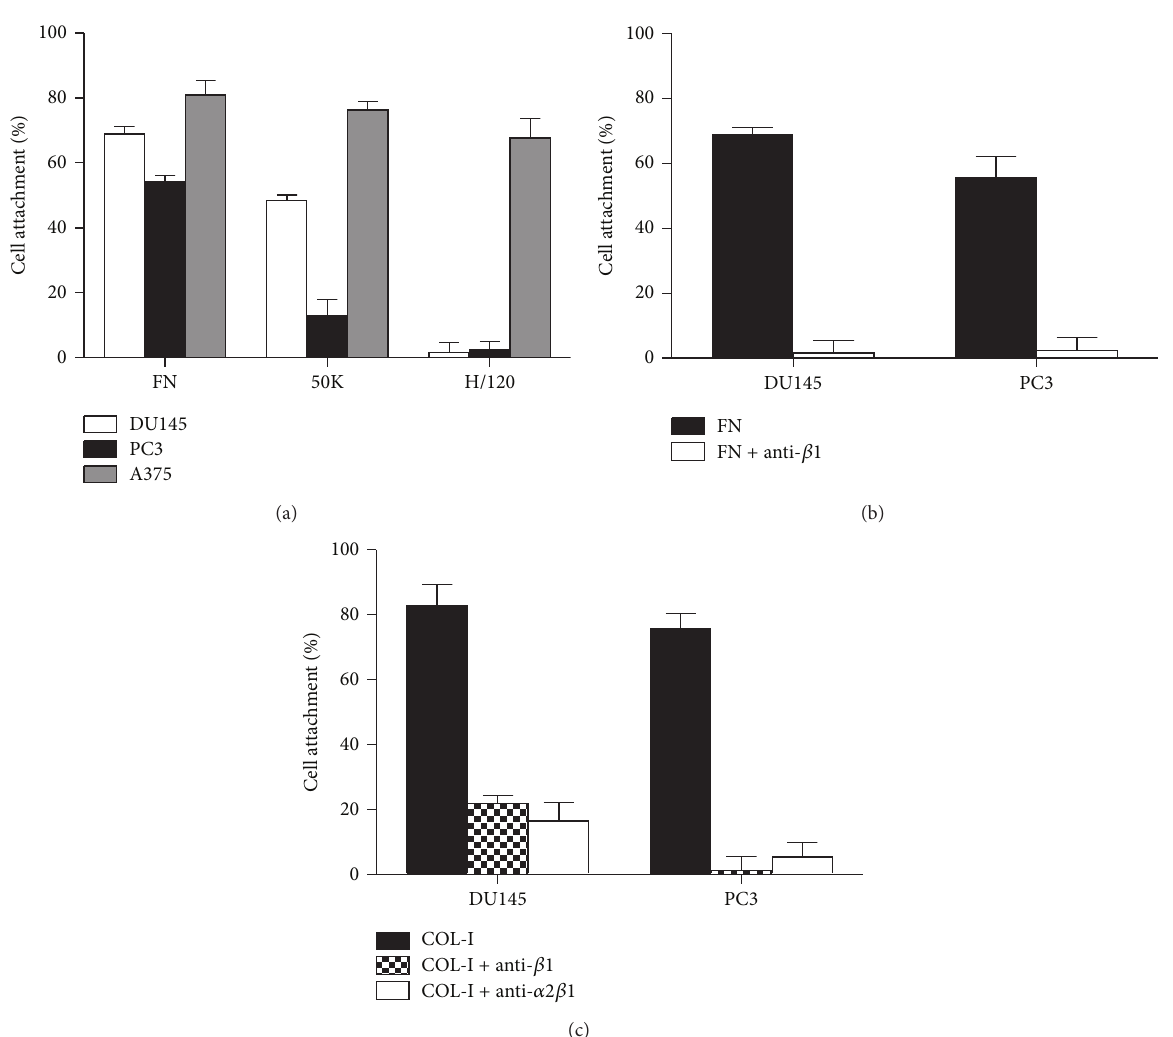
Figure 1: (a) PC3 and DU145 cell attachments on FN, 50K, and H/120. A375 cell was used as a control; A375 is positive for both 𝛼 4 𝛽 1- and 𝛼 5 𝛽 1-mediated cell adhesion on FN. (b) The effect of anti- 𝛽 1 integrin antibody on DU145 and PC3 cells attachment to FN (10 𝜇 g/mL). (c) The effect of anti- 𝛽 1 and anti- 𝛼 2 𝛽 1 integrin antibodies (10 𝜇 g/mL) on DU145 and PC3 cell attachment to COL-I (5 𝜇 g/mL). The level of nonspecific binding, determined from these cells attachment to wells coated with BSA alone, was subtracted. Mouse and rat normal control antibodies have no impact on the levels of DU145 and PC3 cell attachment to FN and COL-I. Values shown are mean ± standard deviation of triplicate